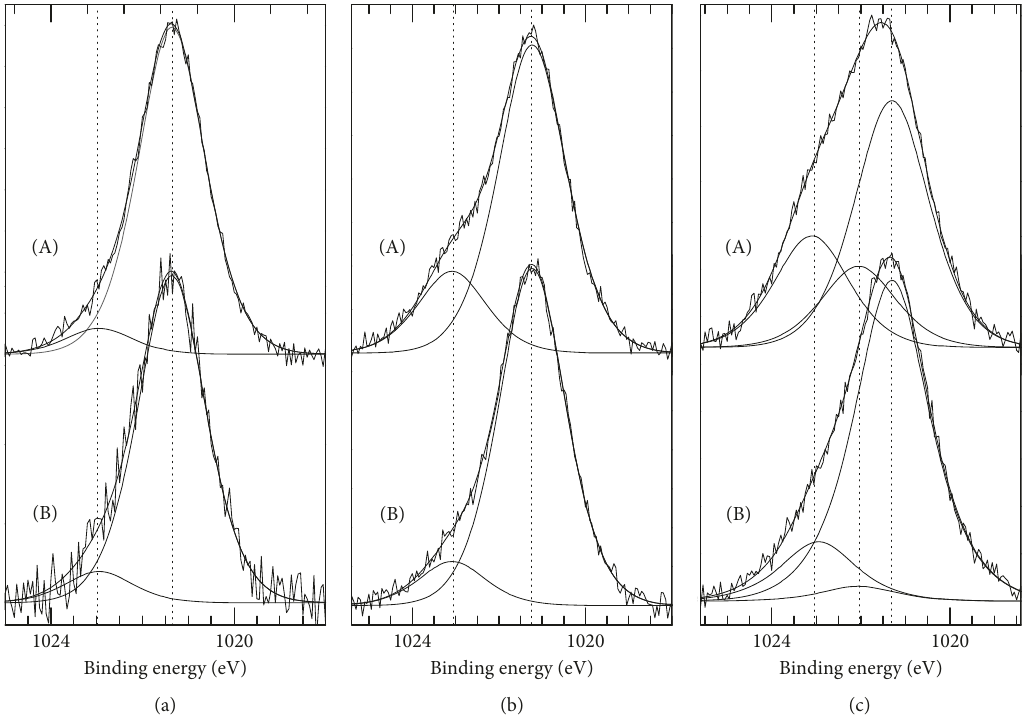
Figure 4: XPS photoelectron spectra of Zn 2p 3/2 for Mn-Zn ferrite: (a) P1-C2O4, (b) P2-CO3, and (c) P3-OH in (A) “as-received” form and (B) after Ar + sputtering (90 s, 2keV, 4.1 µ A/cm 2 ).